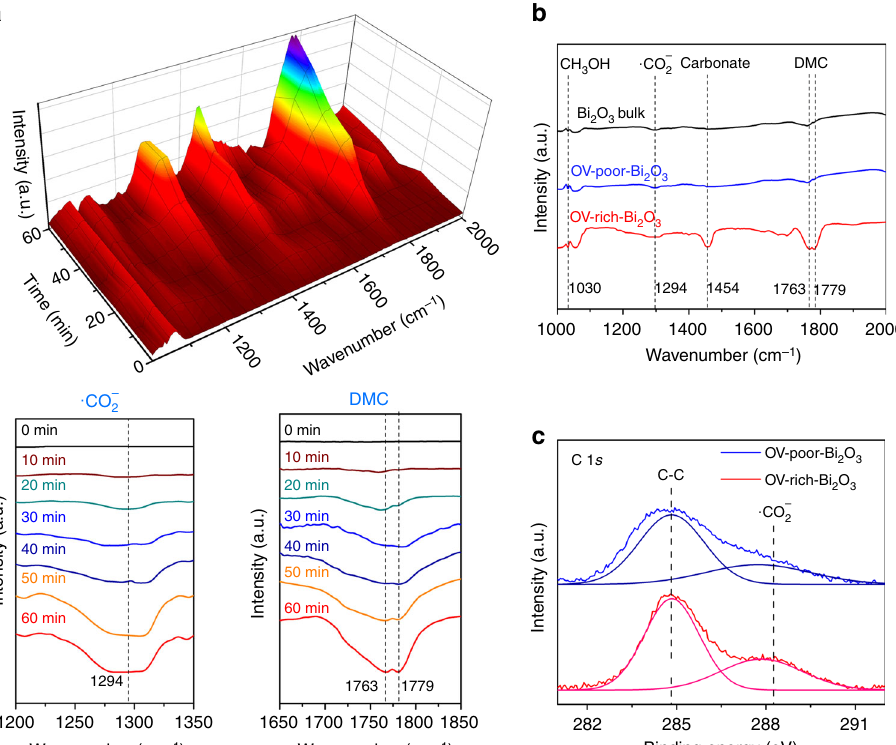
Fig. 4 Reaction mechanism for Bi 2 O 3 nanosheets. a In situ DRIFTS spectra for the adsorption and activation of CO 2 in the presence of CH 3 OH under Xe- lamp irradiation for OV-rich-Bi 2 O 3 nanosheets. Inset at the lower left: the DRIFTS of generation of (cid:129) CO 2 – ; inset at the lower right: the DRIFTS of DMC. b In situ DRIFTS spectra for the catalysts with CO 2 and CH 3 OH under Xe-lamp irradiation for 60 min. c Quasi in situ XPS spectra of OV-rich-Bi 2 O 3 and OV- poor-Bi 2 O 3 nanosheets under the atmosphere of CO 2 (0.2 MPa) at 373